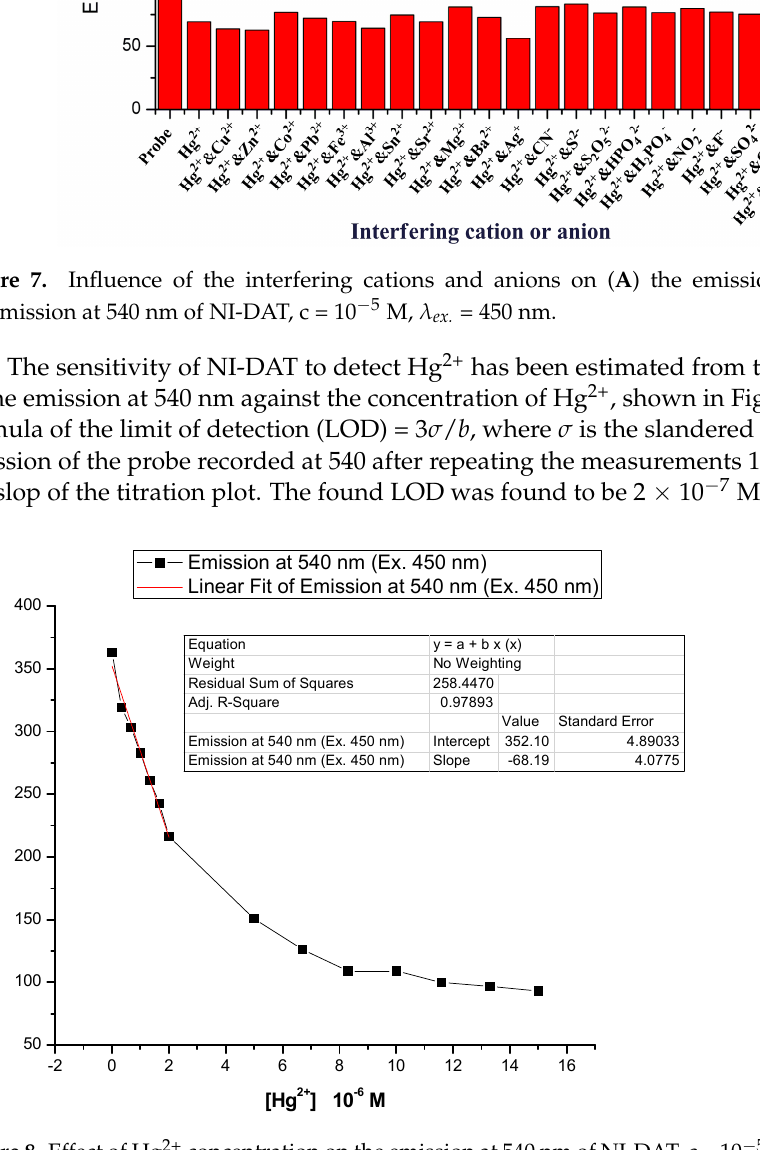
Figure 8. Effect of Hg 2+ concentration on the emission at 540 nm of NI-DAT, c = 10 − 5 M, λ ex . = 450 nm.